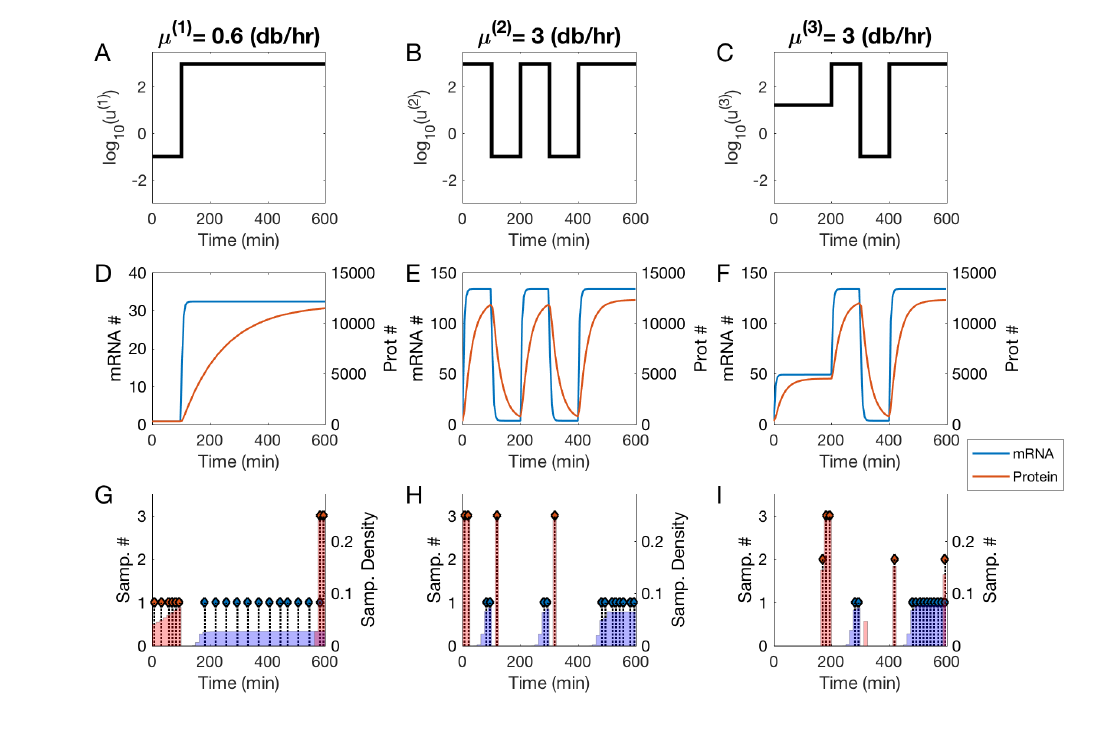
Figure 3. An optimal experiment (designed at the true value of θ ). Each column depicts one sub-experiment, labelled with optimal doubling rates: µ ( 1 ) , µ ( 2 ) and µ ( 3 ) (corresponding to exponential growth rates λ ( 1 ) , λ ( 2 ) and λ ( 3 ) ). The top row ( A – C ) depicts the optimal inputs, u ( 1 ) ( t ) , u ( 2 ) ( t ) and u ( 3 ) ( t ) (on a log scale). The middle row ( D – F ) shows the system response (both mRNA and protein 10 copy number) for each induction profile. The last row shows the sampling densities w shaded areas, blue and red, respectively), for both protein and mRNA, as well as the rounded sampling ( i ) ( i ) schedule, s (depicted by the stem plot). The optimality score of this experiment was − rna and s prot